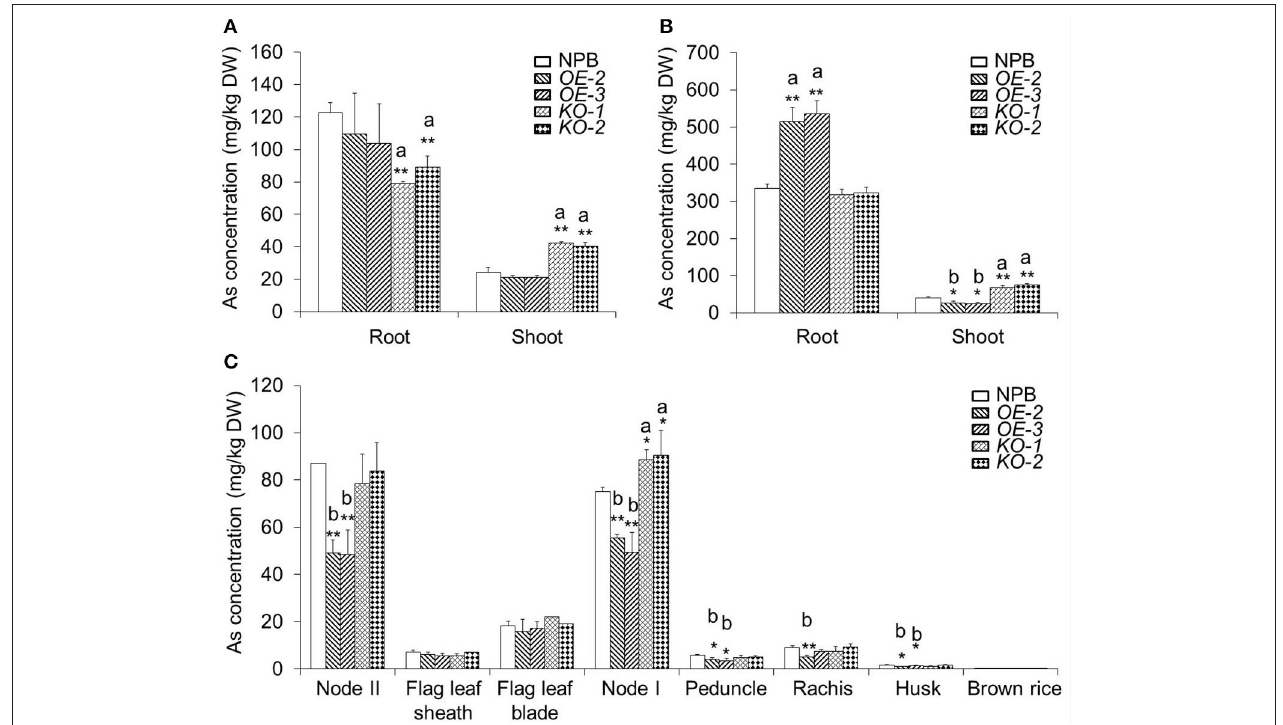
FIGURE 6 | The As contents in various organs of wild-type NPB, OsARM1-KOs , and OsARM1-OEs . (A,B) The As levels in roots and shoots of Nipponbare, OsARM1-KOs , and OsARM1-OEs . Two-week-old wild-type NPB, OsARM1-KOs ( KO-1 and KO-2 ), and OsARM1-KOs ( OE-2 and OE-3 ) seedlings were exposed to Kimura B nutrient solution containing 2 µ M (A) or 25 µ M As(III) (B) for 7 days. The root and shoot samples were harvested separately for As determinations by atomic fluorescence spectrometry. (C) As contents in different organs in the aboveground parts of wild type NPB, OsARM1-KOs ( KO-1 and KO-2 ), and OsARM1-KOs ( OE-2 and OE-3 ) in As-containing soil (20mg As per 1kg soil) until the ripening stage. The organs were sampled and subjected to As determination by atomic fluorescence spectrometry. The experiments were repeated three times and the average data are shown. Data are means ± SD ( n = 3) calculated from three independent experiments. Asterisks indicate significant differences from wild type (* P < 0.05; ** P < 0.01 by Student’s t -test). “a” and “b” indicate values that are significantly higher or lower, respectively, in the transgenic lines than in wild